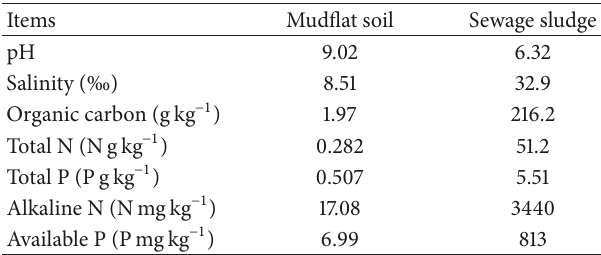
Table 1: Basic chemical properties of the coastal mudflat salt-soil and sewage sludge used in this